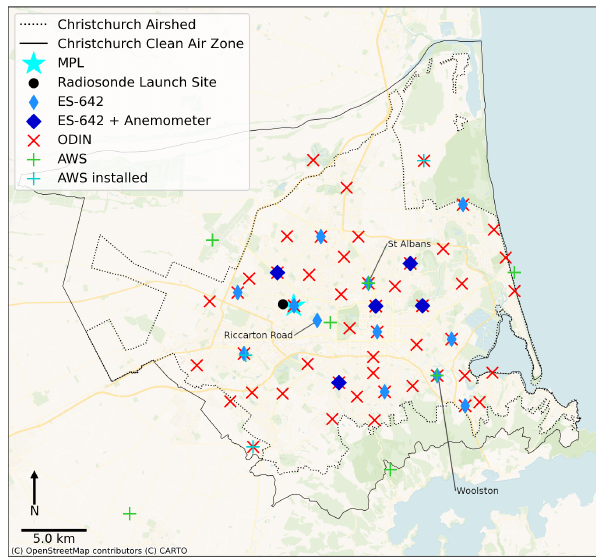
Figure 2. Locations of the instruments deployed during the MAPM field campaign and the AWSs operated by MetService and NIWA. The solid black line indicates the boundary of the Christchurch Clean Air Zone, and the black dotted line indicates the boundary of the Christchurch Airshed. Locations of AWSs operated by mem- bers of the public are not shown. © OpenStreetMap contributors 2020. Distributed under a Creative Commons BY-SA